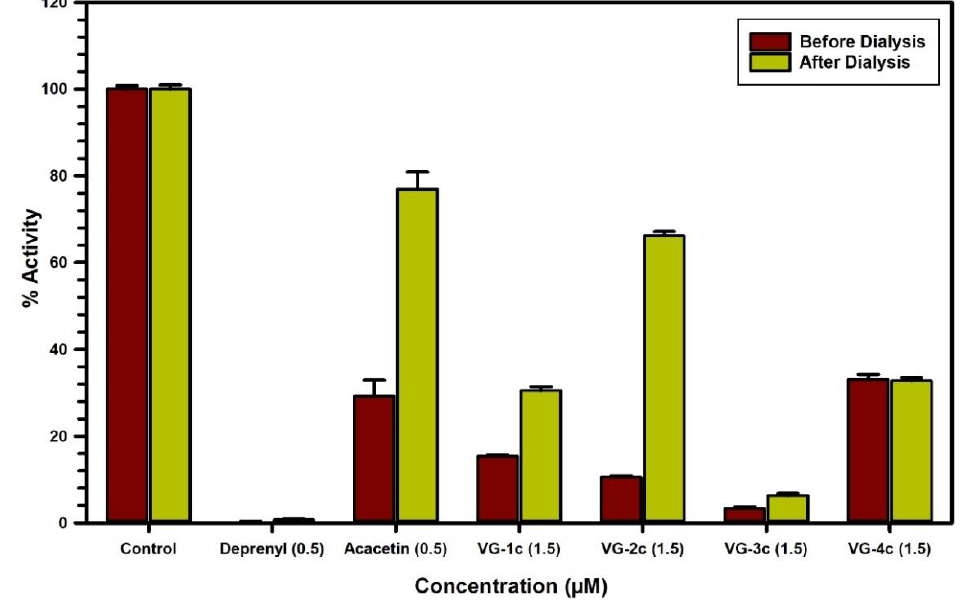
Figure 8. Analysis of the nature of binding of deprenyl (0.5 μM), acacetin (0.5 μM), 1c (1.5 μM), 2c (1.5 μM), 3c (1.5 μM), and 4c (1.5 μM) with recombinant human MAO -B by recovery of catalytic